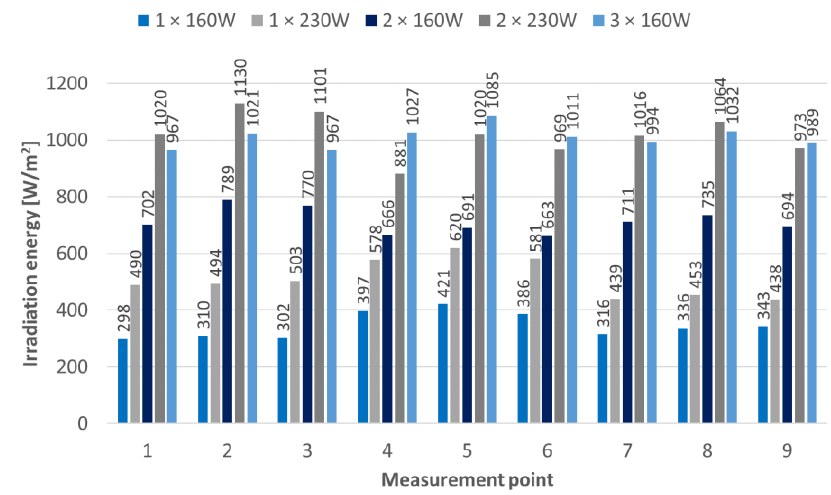
Figure 5. Irradiation intensity measured at the surface of the plate for the selected combinations of halogen lamp power.